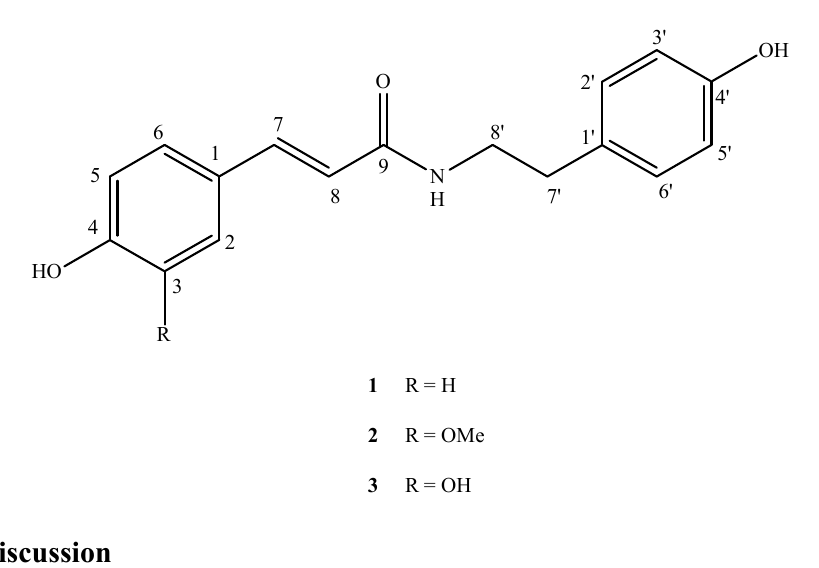
Figure 1. Structures of compounds 1 – 3